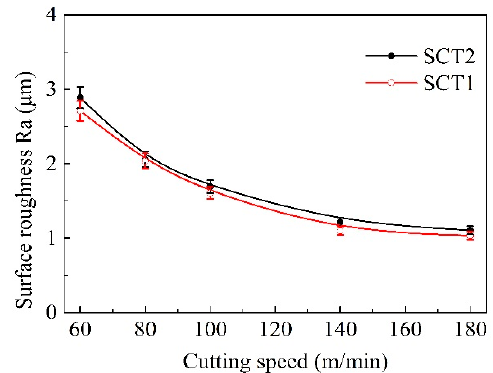
Figure 12. Surface roughness of machined workpiece with SCT1 and SCT2 at different cutting speeds ( a p = 0.2 mm, f = 0.1 mm/r).